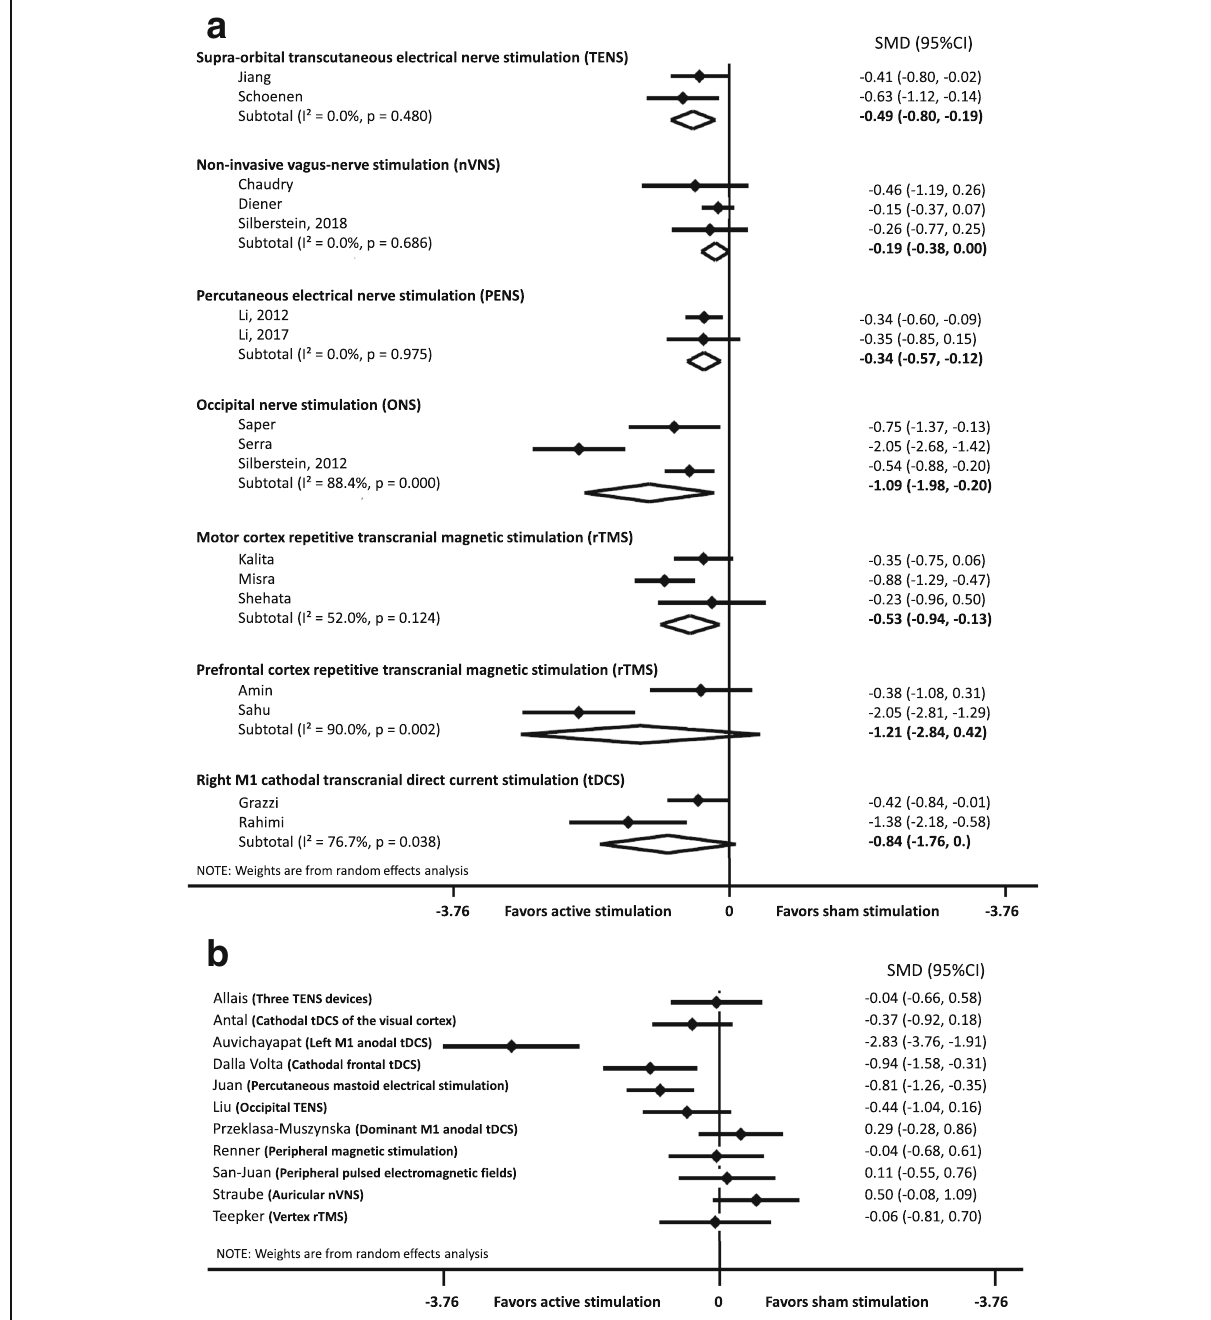
Fig. 3 Forest plot of the 27 studies included in the quantitative synthesis for preventive migraine treatment (Panel a , at least two studies. Panel b , single studies). The common outcome was the reduction of headache days in the active treatment and control groups (the higher the reduction, the more effective the treatment). Studies using the same techniques are pooled together. All references for studies in this figure are listed in the online supplementary references. SMD: standardized mean difference, tDCS: transcranial direct current stimulation. Three studies were not included in the quantitative synthesis: Allais et al., [23] (3 TENS devices); Bono et al., [24] (occipital TENS); Jia et al., [25] (PENS); Kosari et al., [26] (tDCS over the visual